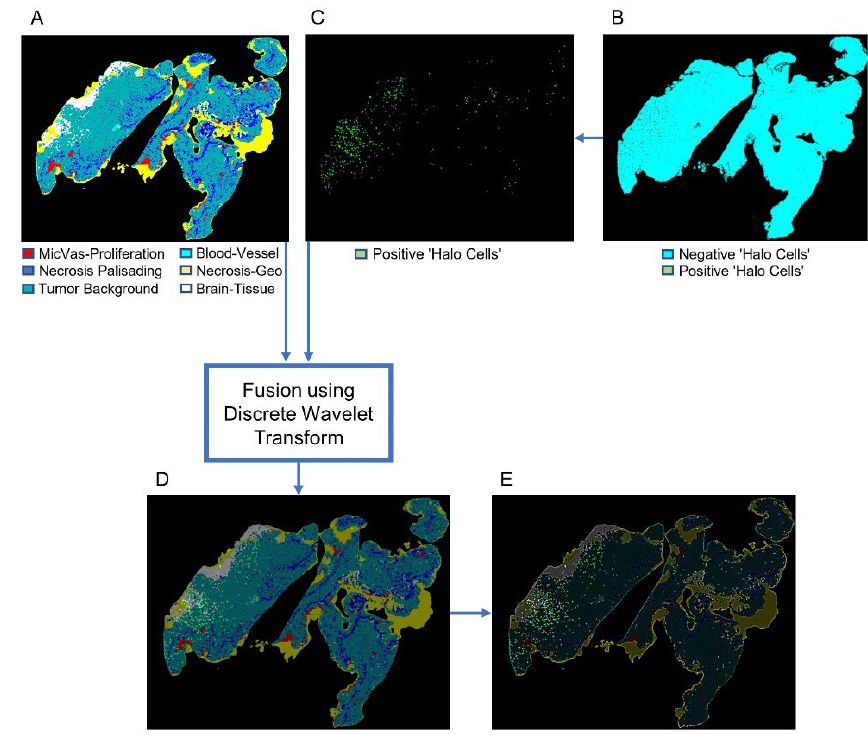
Figure 6. Image fusion using Discrete Wavelet Transform. ( A ) Original heatmap showing histological features. ( B ) Heatmap showing cell-level features (“halo cells” and negative areas). ( C ) Thresholding, registration and alignment, resulting in a heatmap showing only the cells of interest. ( D ) The Discrete Wavelet Transform was used to fuse heatmaps ( A , C ); ( E ) shows the same image as ( D ) but with greater brightness to emphasize the location of “halo cells” (bright dots). Whole slide images are shown.